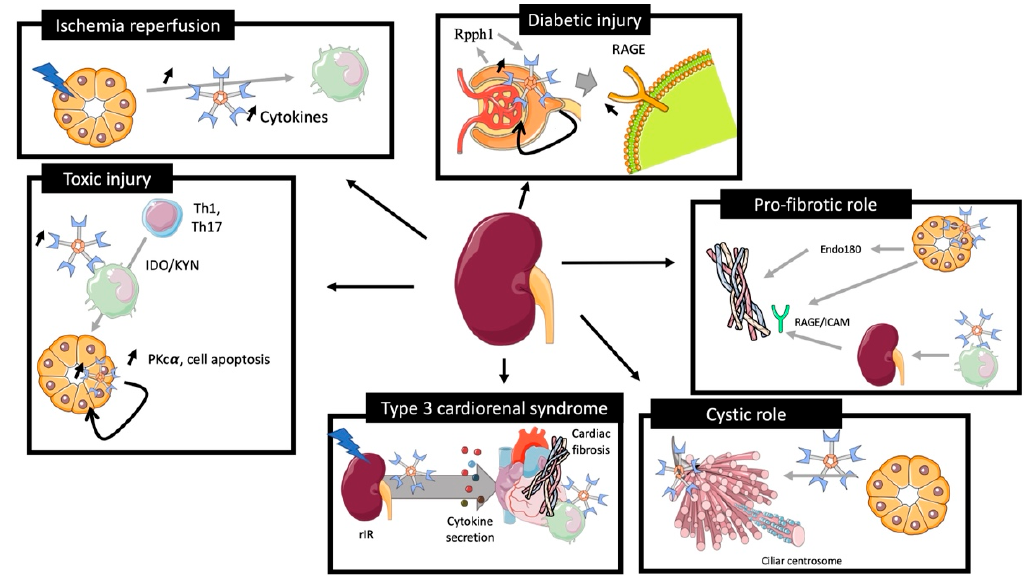
Figure 3. Role of galectin-3 in preclinical models of kidney injury. rIR leads to an increase of plasma and renal Gal-3 expression associated with acute tubular injury, promoting cytokine expression and immune cells recruitment. Toxic renal injury induces Gal-3 associated Th1 and Th17 recruitment for renal reparation and Gal-3 tissular associated PKc 𝛼 cell apoptosis. Diabetic models induce an overexpression of Gal-3 via the Rpph1 pathway, promoting AGE downregulation via an upregulation of RAGE. In the cystic model, Gal-3 was expressed in cystic centrosome cilia and its inhibition aggravates the development of cyst. Gal-3 expression induces collagen formation via the endo180 receptor and the RAGE/ICAM pathway. Gal-3 is increased in plasma during type 3 cardiorenal syndrome leading to cytokine secretion, cardiac Gal-3-associated immune cells, and fibrosis induction.